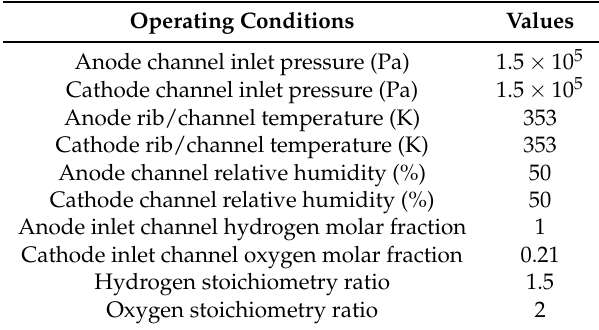
Table 2. Fuel cell operating conditions for